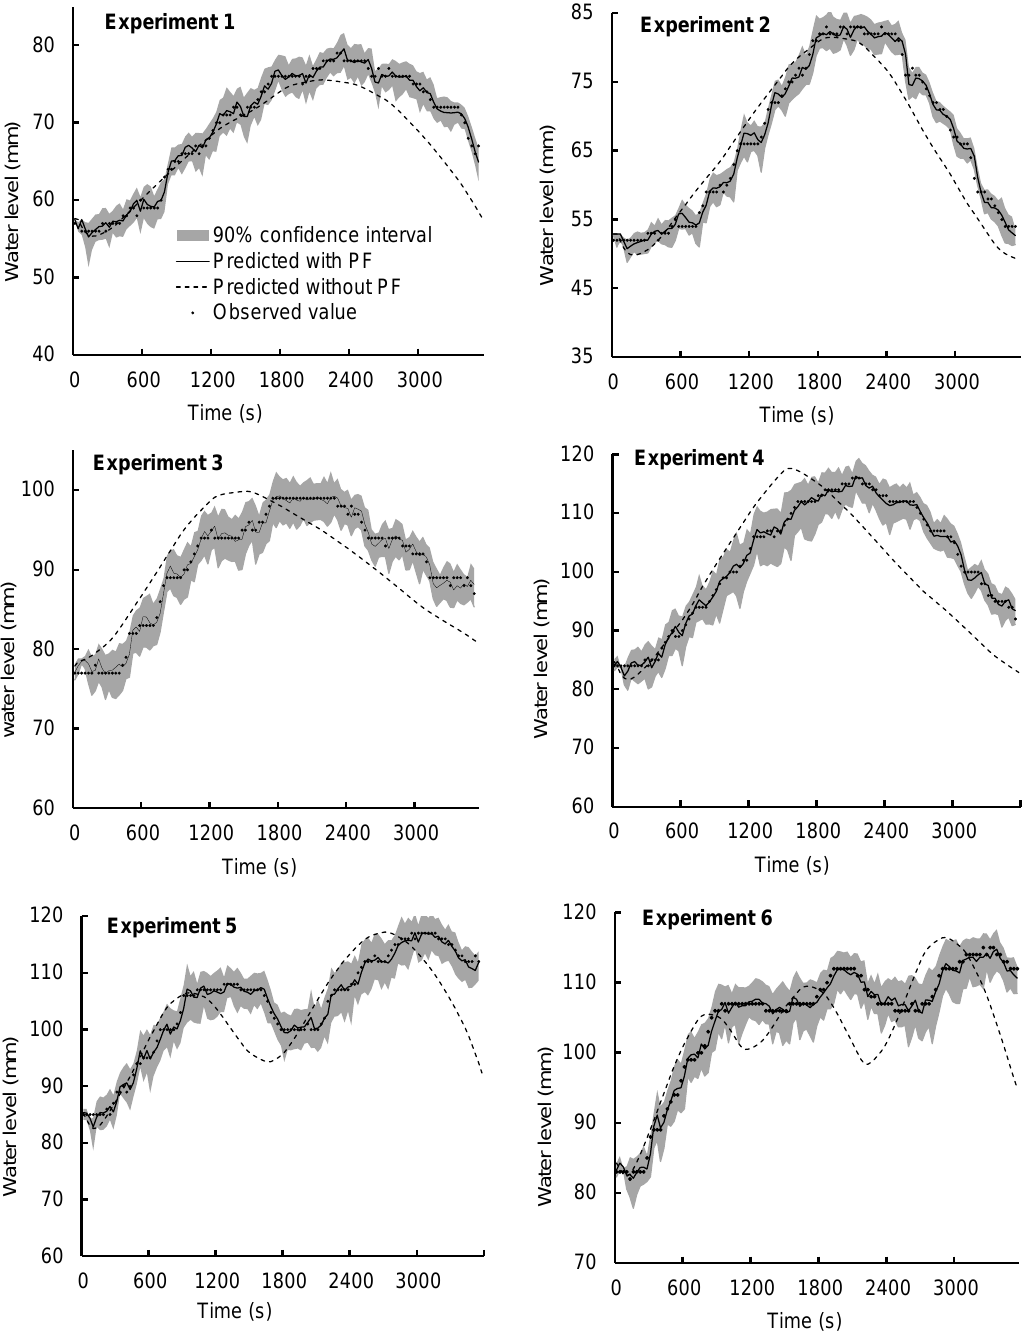
Figure 4. Comparison between observed and predicted water level processes. The dots represent the observed values. The black line represents the mean of the particles simulated by assimilation model. The dotted line represents the water level calculated by the hydrodynamic model. The gray shaded area represents the 90% confidence